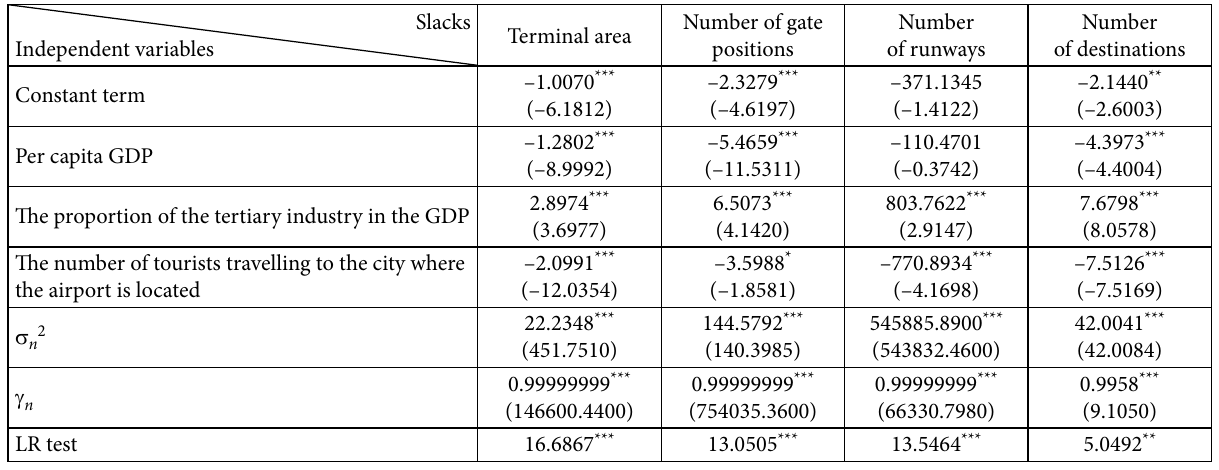
Table B.1. SFA estimation results in 2013